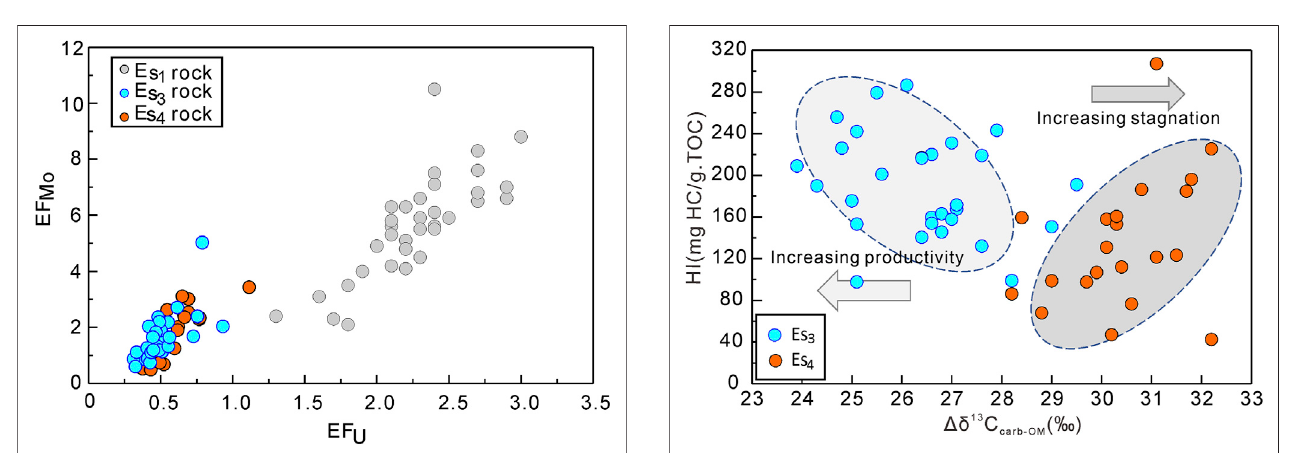
FIGURE 11 | Crossplot of EF U vs. EFMo for Es 3 and Es 4 source rocks in the Langgu sag and Es1 rocks in the Raoyang sag, Jizhong subbasin. The data of Es1 after Yin et al. (2018).